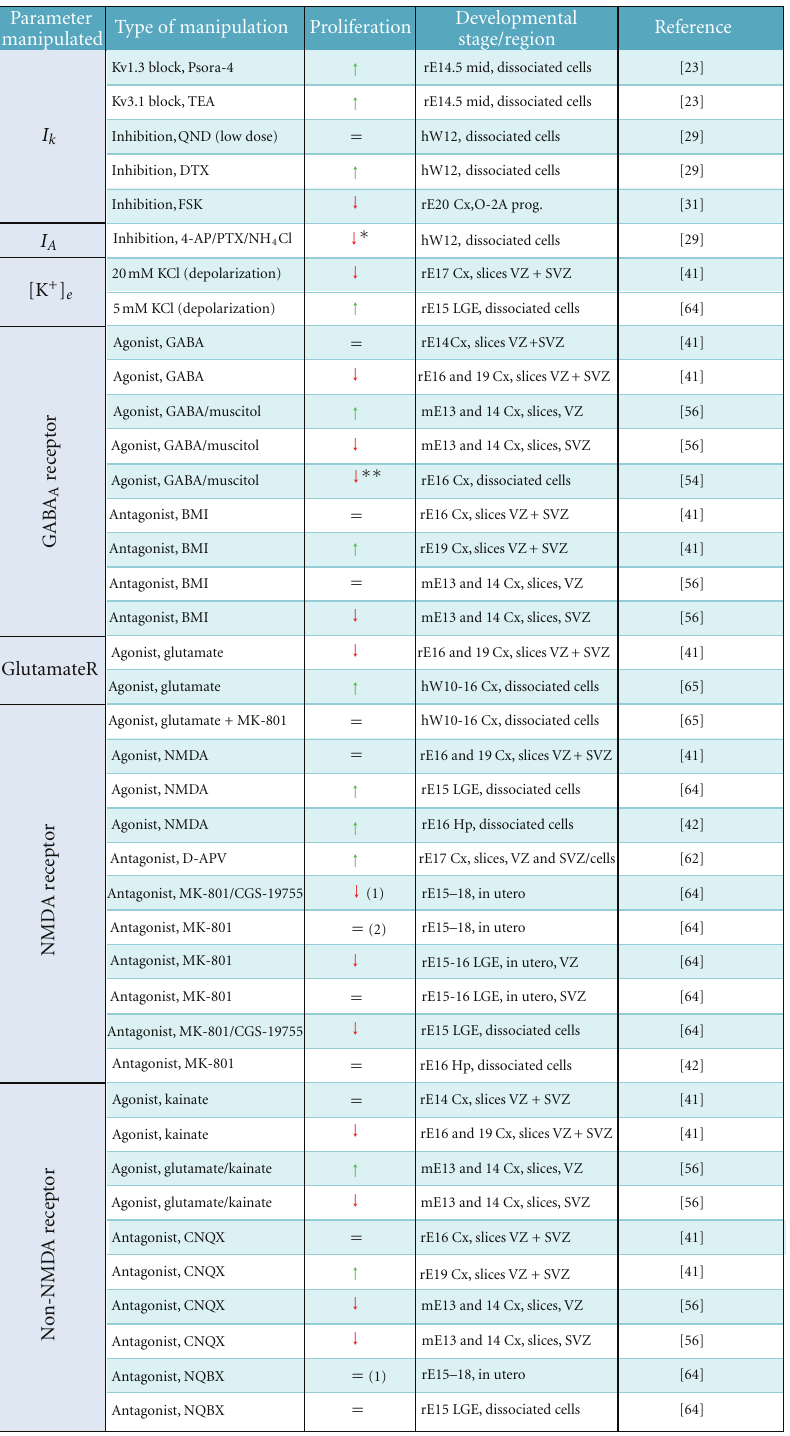
Figure 2: E ff ects upon manipulation of ion channels or extracellular ionic composition on the proliferation of NSC. Green and red arrows indicate increased or decreased proliferation, respectively, as deduced from incorporation of thymidine analogues or number of neurons in the adult striatum (1) or motor cortex (2). Agonists and antagonists used (Psora-4 = 5-(4-phenylbutoxy)psoralen; TEA = tetraethylammonium chloride; QND = quinidine; DTX = α -dendrotoxin; FSK = forskolin; 4-AP = 4-aminopyridine; PTX = phrixotoxin; BMI = biculline methionine; D-APV = D(-)-2-amino-5-phosphonopentanoicacid; CNQX = 6-cyano-7-dinitroquinoxaline-2,3-dione; NQBX = 1,2,3,4-tetrahydro-6-nitro-2,3-dioxo-benzol(f)-quinoxaline-7-sulfonamide) as well as source of NSC form di ff erent species (r = rat; h = human; m = mouse), developmental stage (E = embryonic day; W = embryonic week), or region (mid = midbrain; Cx = cortex; LGE = lateral ganglionic eminence; Hp = hippocampus; VZ = ventricular zone; SVZ = subventricular zone) are indicated. ∗ reduced viability; ∗∗ only in the presence of bFGF; O-2A = oligodendrocyte